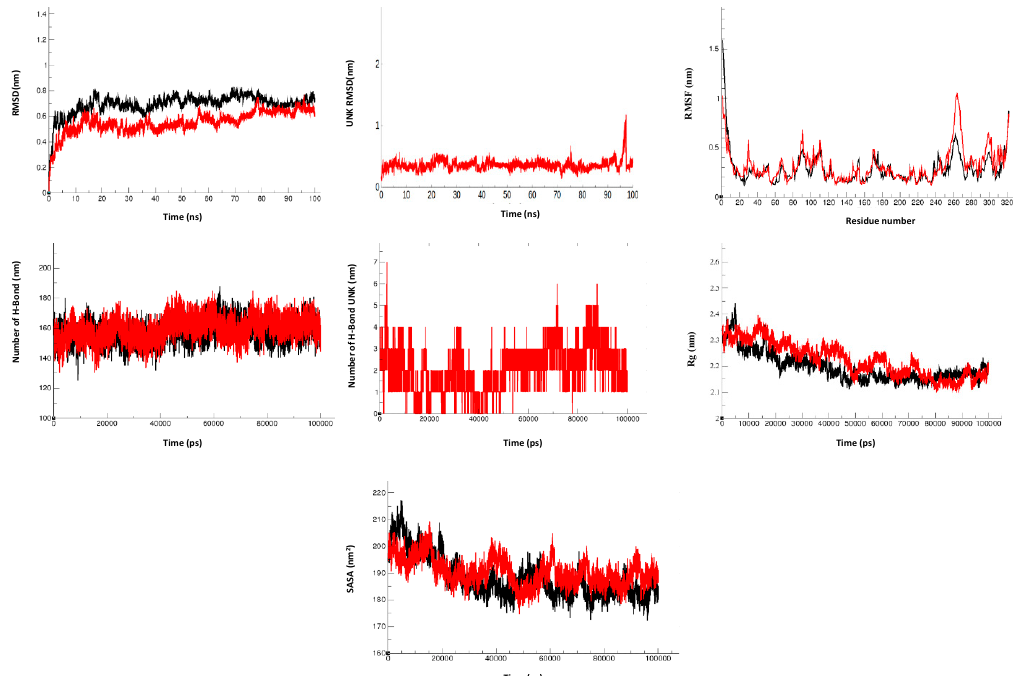
Figure 7. Molecular dynamics simulations of HPPA with HEV-MTase: RMSD of the C α backbone of apo-MTase and its complexes with respect to time (100 ns), RMSD of compounds over 100 ns, RMSF of Ca atoms of MTase complexes over the 100 ns. Stability of MTase from HEV-MTase: The number of hydrogen bond interactions between MTase and compounds during simulation are shown. The radius of gyration (Rg) of MTase and in complex with compounds over the simulation. Total solvent accessible area (SASA) with respect to time is shown. The apo-MTase (black) and its complex with inhibitor HPPA (red) are